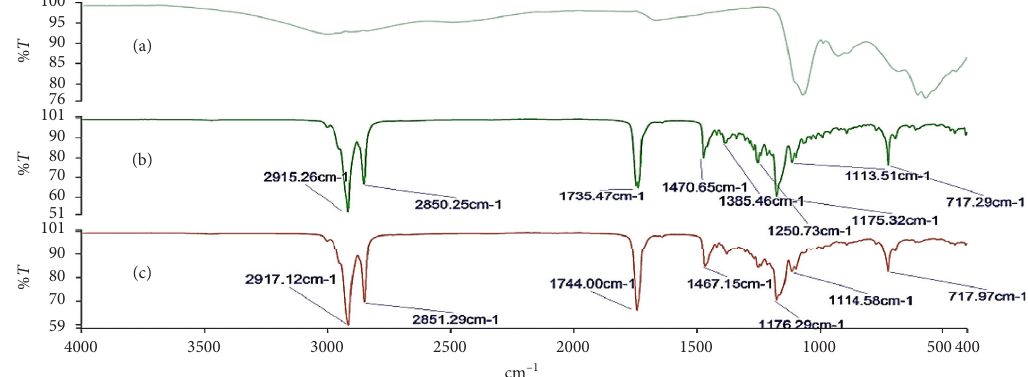
Figure 3: FT-IR spectra of (a) alum, (b) shea butter, and (c) shea butter+alum (1 :1).